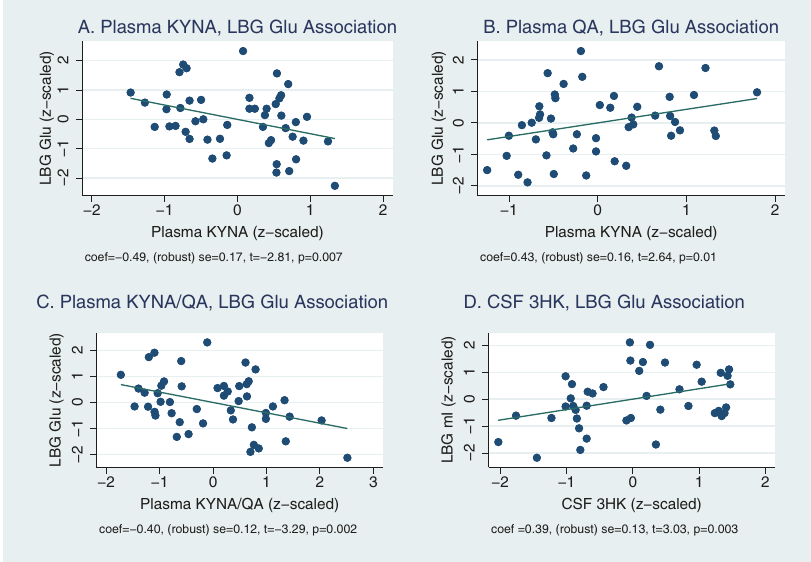
Fig. 1 KP-MRS associations. The fi gure represents the partial ( A , B ) and simple regression plots ( C , D ) demonstrating the association between kynurenine pathway (KP) metabolites on the x-axis and magnetic resonance spectroscopy (MRS) – based markers in the left basal ganglia on the y-axis. All values were normalized (using Box-Cox Power Transform) and z -scaled. These are simpli fi ed least squares models compared with the more complex lasso regression used in the text. A represents the association between plasma kynurenic acid (KYNA) and left basal ganglia (LBG) glutamate (LBG Glu), B between plasma quinolinic acid (QA) and LBG glutamate (Glu), C between plasma KYNA/QA ratio and LBG Glu, and D between cerebrospinal fl uid (CSF) 3-hydroxykynurenine (3HK) and LBG myo-inositol (LBG mI). The individual coef fi cients and their signi fi cance values are indicated under each graphlet. The voxel used for MRS acquisition (MRS-LBG-VOI) is demonstrated as an inset in Fig.